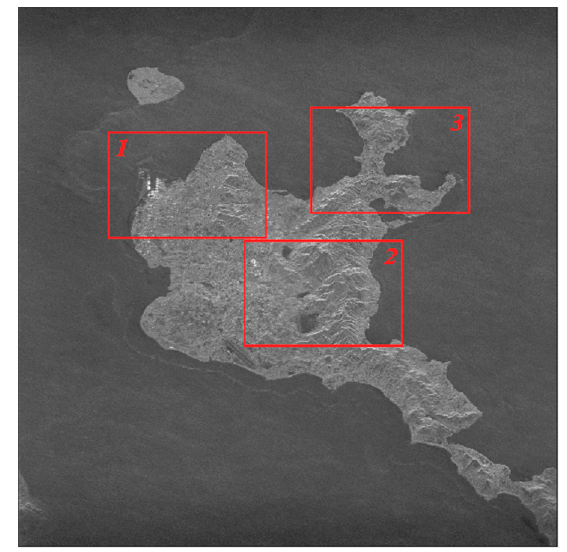
Figure 22. Chosen regions in real SAR data.